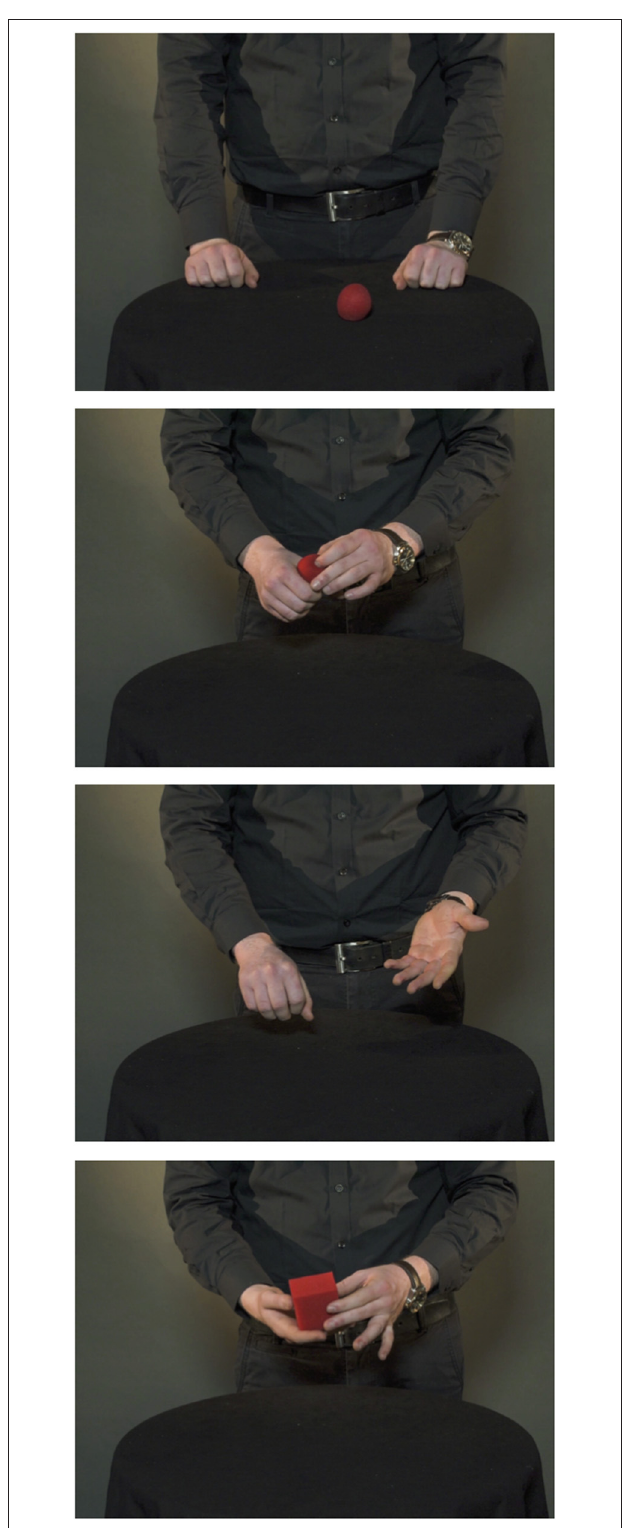
FIGURE 3 | Picture sequence illustrating the magic trick Ball to cube (Example 3). The full clip is available at https://www.youtube.com/watch?v=